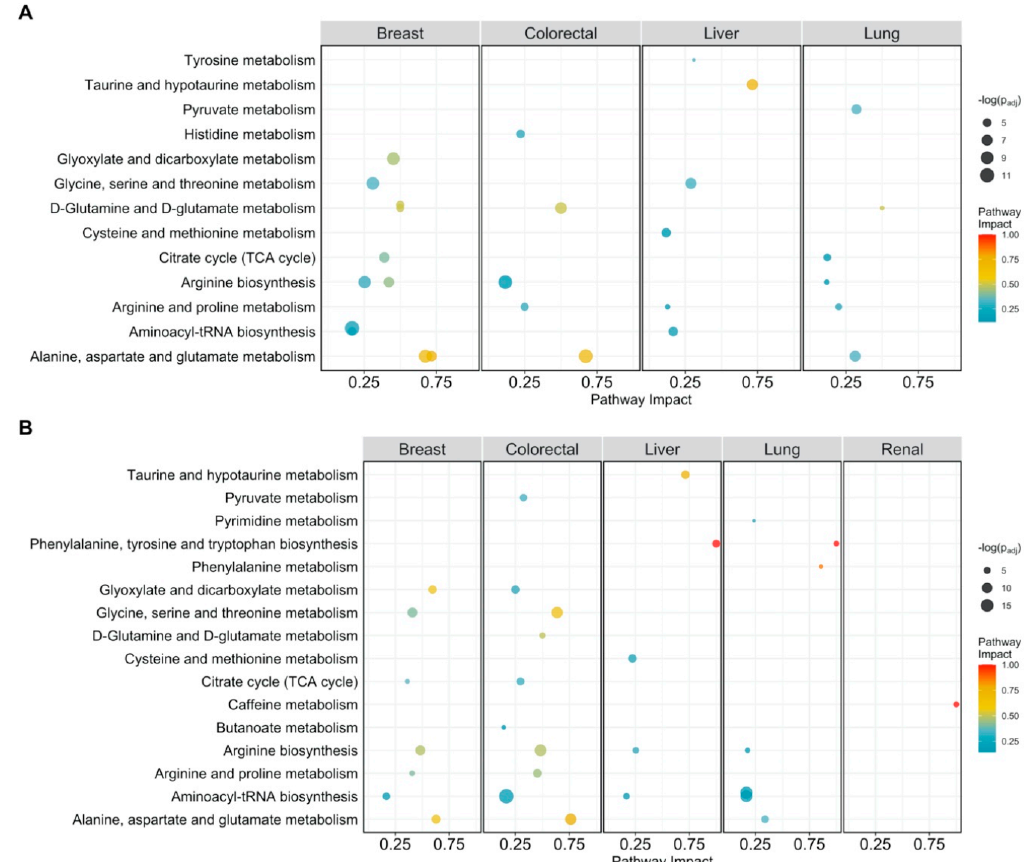
Figure 1. Pathway analysis plot showing the impact on metabolic pathways that are significantly enriched ( p adj < 0.05 ) and have a pathway impact score > 0.1 per cancer type. Datapoints are colored according to their impact score. ( A ) Pathway impact according to differentially abundant metabolites ( p adj < 0.05 ); ( B ) pathway impact according to differentially connected metabolites (Benjamini-Hochberg adjusted p -value p adj <